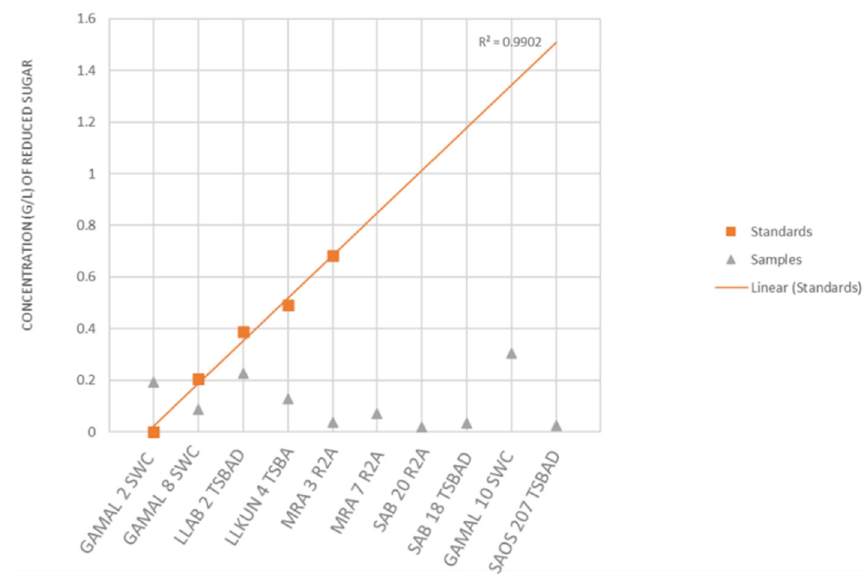
Figure 6. Determination of reducing sugar concentration by DNS method.